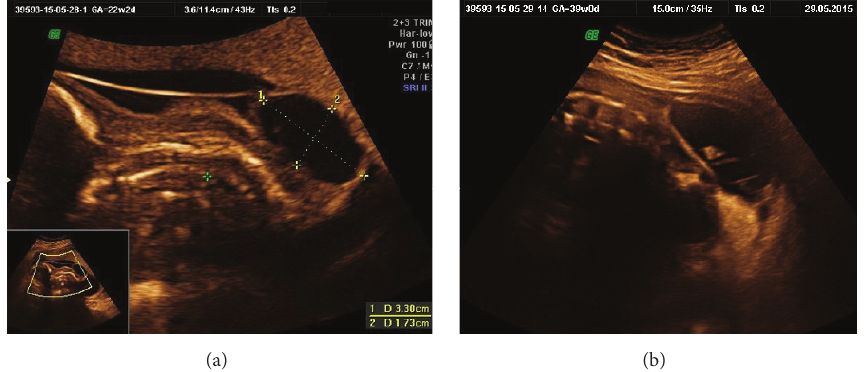
Figure 3: (a and b) show two cases of neural tube defect diagnosed at advanced gestational ages of 22 weeks and 39